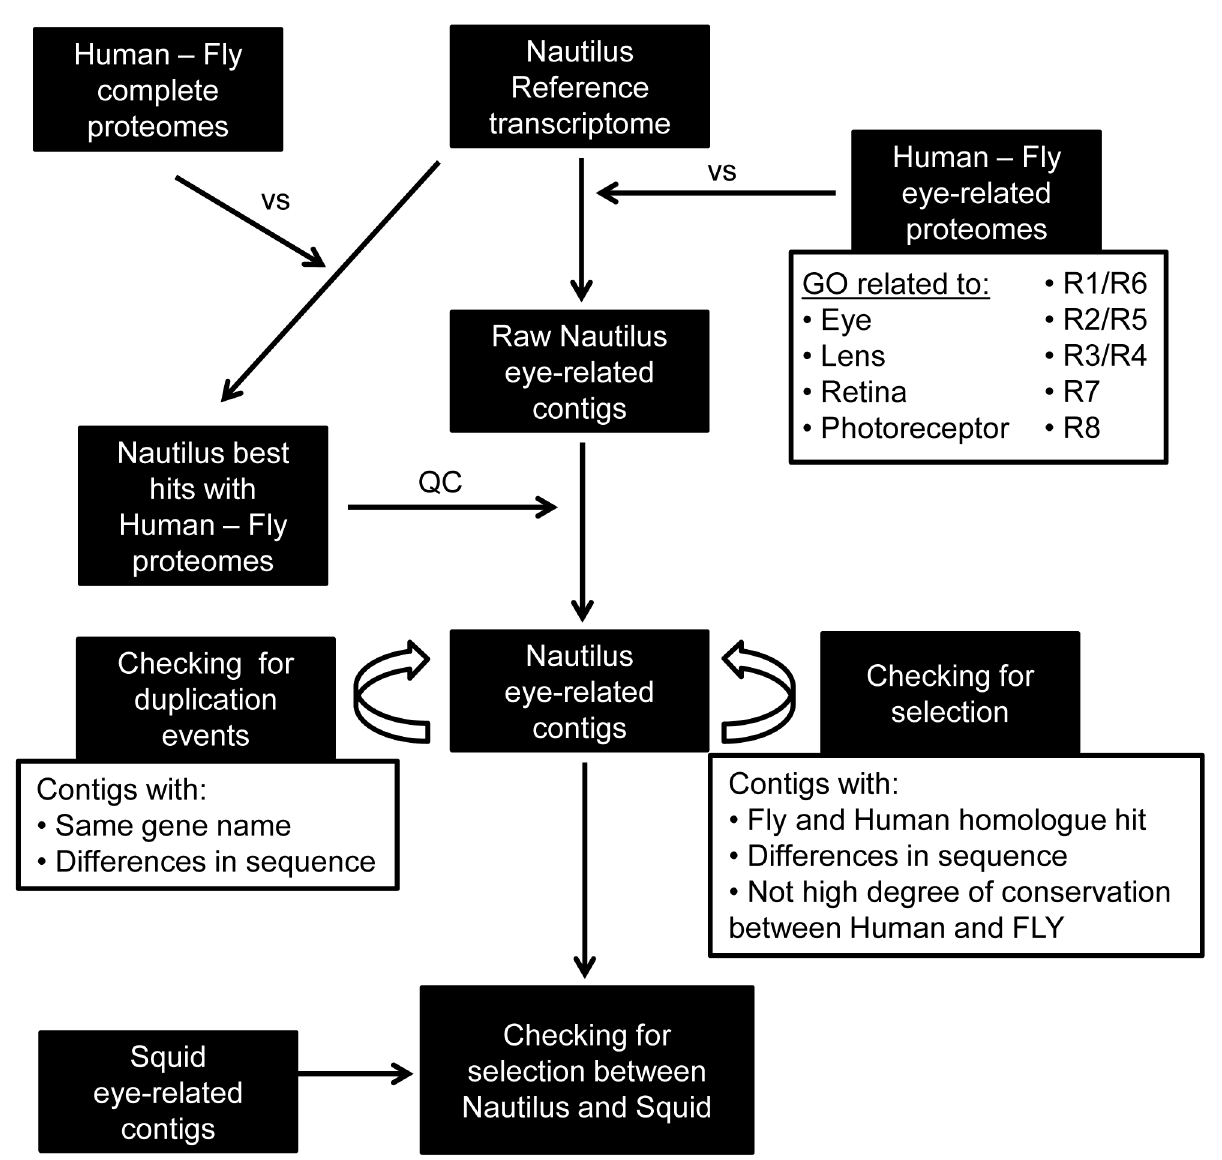
Figure 1. General scheme of work flow. Nautilus transcriptome was compared to Human and Drosophila eye-related proteomes taken from UniProt based on GO terms. The raw eye-related contigs were compared with the results of the comparison between the transcriptome and the complete Human and Drosophila proteomes in order to ensure the best hits of these contigs (quality control: QC). The eye-related contigs were analyzed for duplication events and gene selection. Same procedure was used for the squid transcriptome. The final eye-related contigs were also compared between the Nautilus and squid. doi: 10.1371/journal.pone.0078054.g001 Human NF2 (CAG30416.1), Drosophila Nf1 (AAB58976.1) and Drosophila Merlin (AAB08449.1).